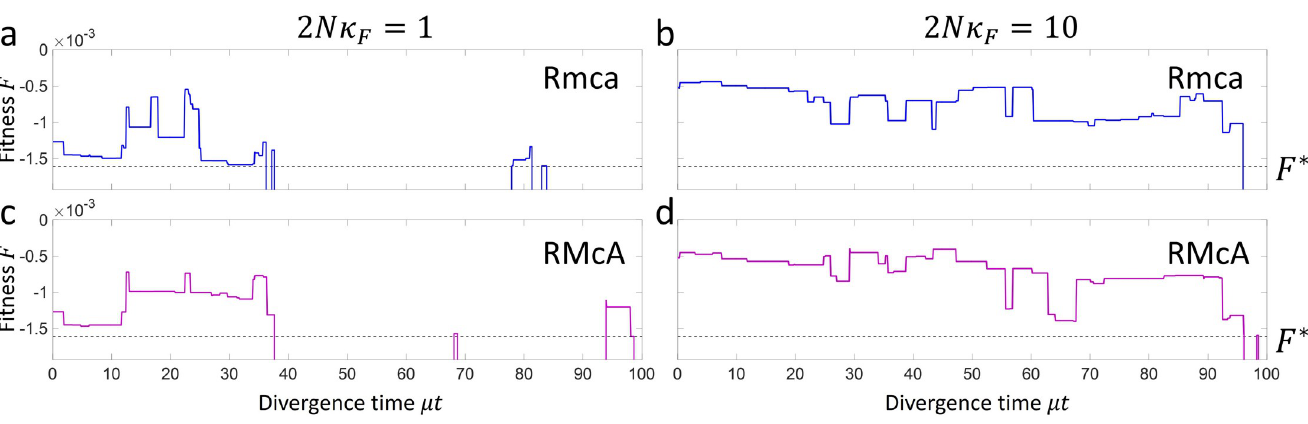
Fig 2. Histogram of the fitness of populations over single long runs as a function of the population scaled fitness contribution 2 N κ